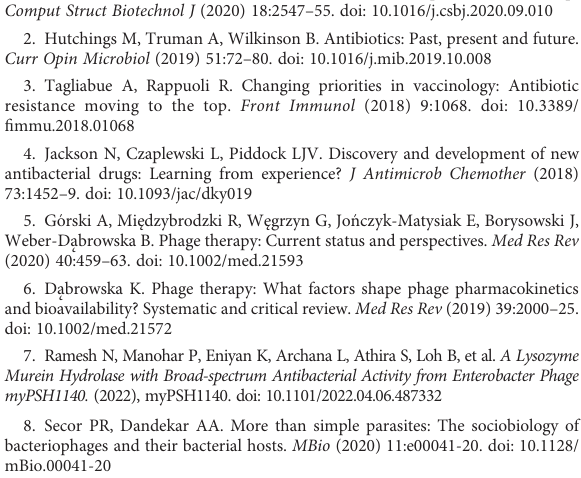
SUPPLEMENTARY FIGURE 6 Changes in the absolute leukocyte counts in the blood of chickens receiving phage therapy or antibiotic therapy after 6, 20, 28 and 34 days of experiments. Results are presented as mean values ± SD. Statistical analyseswereperformedbyKruskal-Wallistestand post-hoc Dunntestor ANOVA and post-hoc Tukey test. The signi fi cance of differences between controls and particular treated groups are observed and marked by: asterisks (*) vs. saline control; (#) vs. phage control (group 2); ( a ) vs. infected control (group 3); ( g ) vs . termination 2. p < 0.001 (***, ###, aaa , ggg ); p< 0.01 (**, ##, aa , gg );